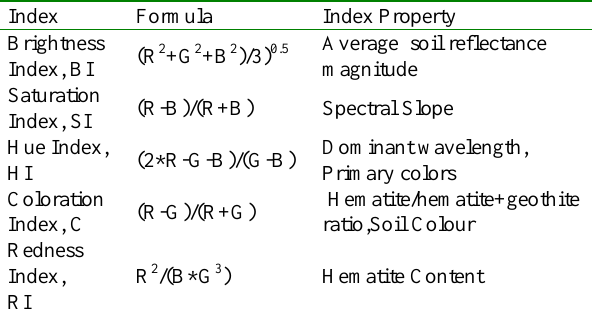
Table 2: Spectral color indices of Thematic Mapper